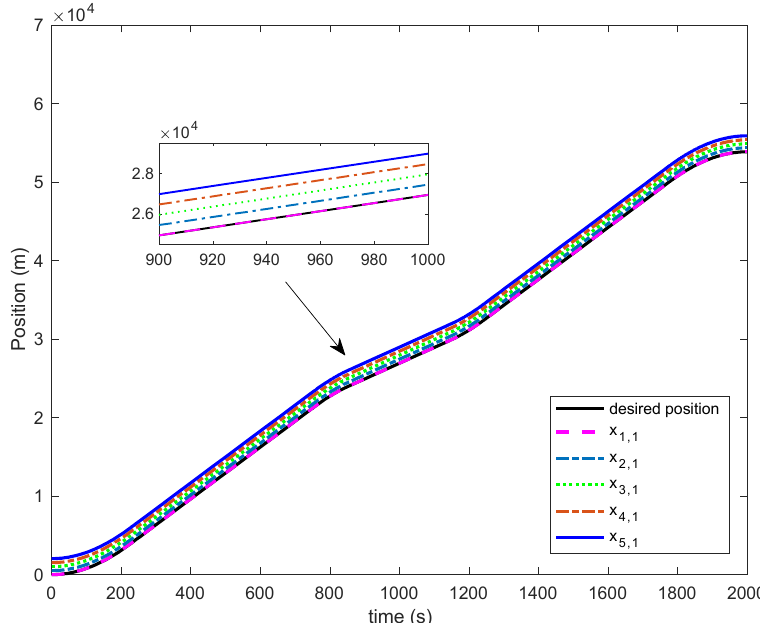
Figure 2. Desired position and position tracking performance of each train.